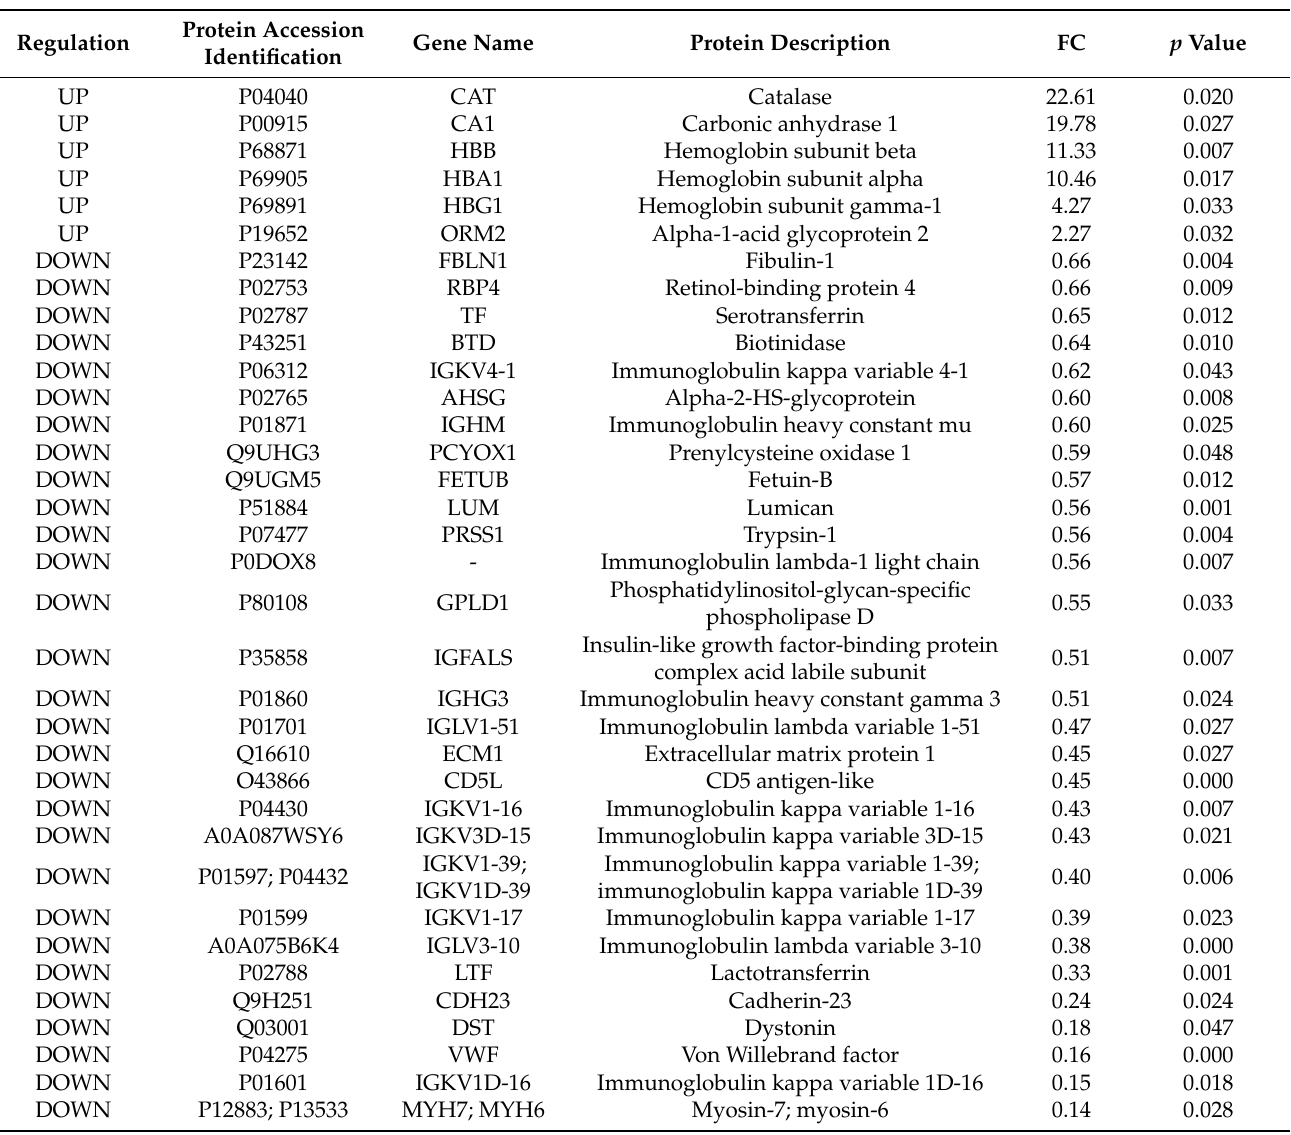
Table 2. Thirty-five differentially expressed proteins between the experimental and control